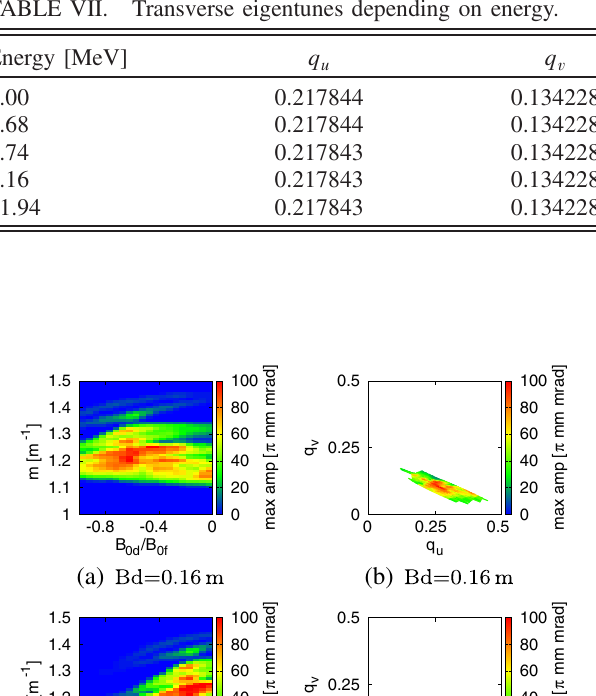
FIG. 11. Stable area in m and B 0 q and q space (b, d, f, h) depending on the length of u v